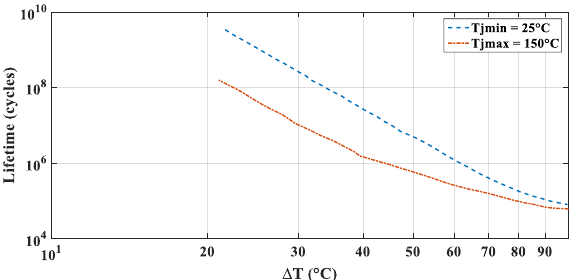
Figure 9. Power cycling lifetime curve for the Fuji U-series IGBT module.